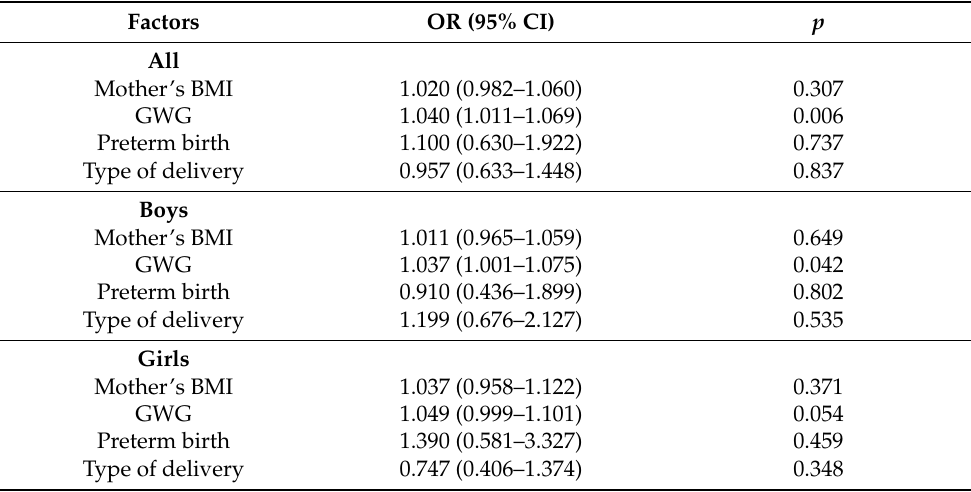
Table 5. Logistic regression of the odds of overweight and obesity in